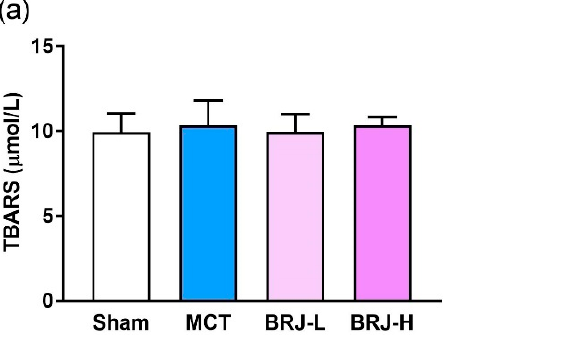
Figure 4. Effects of BRJ supplementation on NO levels in MCT-injected rats. ( a ) plasma nitrite, ( b ) plasma nitrate, ( c ) RV nitrite, ( d ) RV nitrate. Each column and bar represent the mean ± SEM values of 6–9 experiments. One-way analysis of variance with the Holm–Sidak post hoc test was performed to determine the significance. Abbreviations: BRJ, beetroot juice; NO, nitric oxide; MCT, monocrotal- ine; RV, right ventricle; BRJ-L, low-dose beetroot juice; BRJ-H, high-dose beetroot juice.